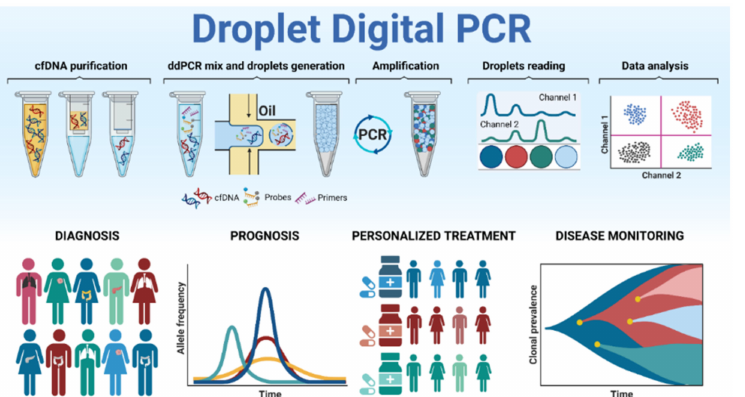
Figure 2. Summary of the ddPCR alterations screening process. The purified cfDNA is divided into thousands of oil droplets together with specific primers and probes. The ddPCR currently has several applications such as cancer diagnosis, prognosis, personalized treatment administration, and disease